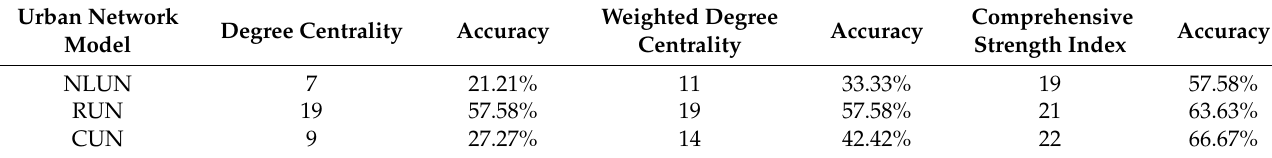
Table 5. Accuracy of Core